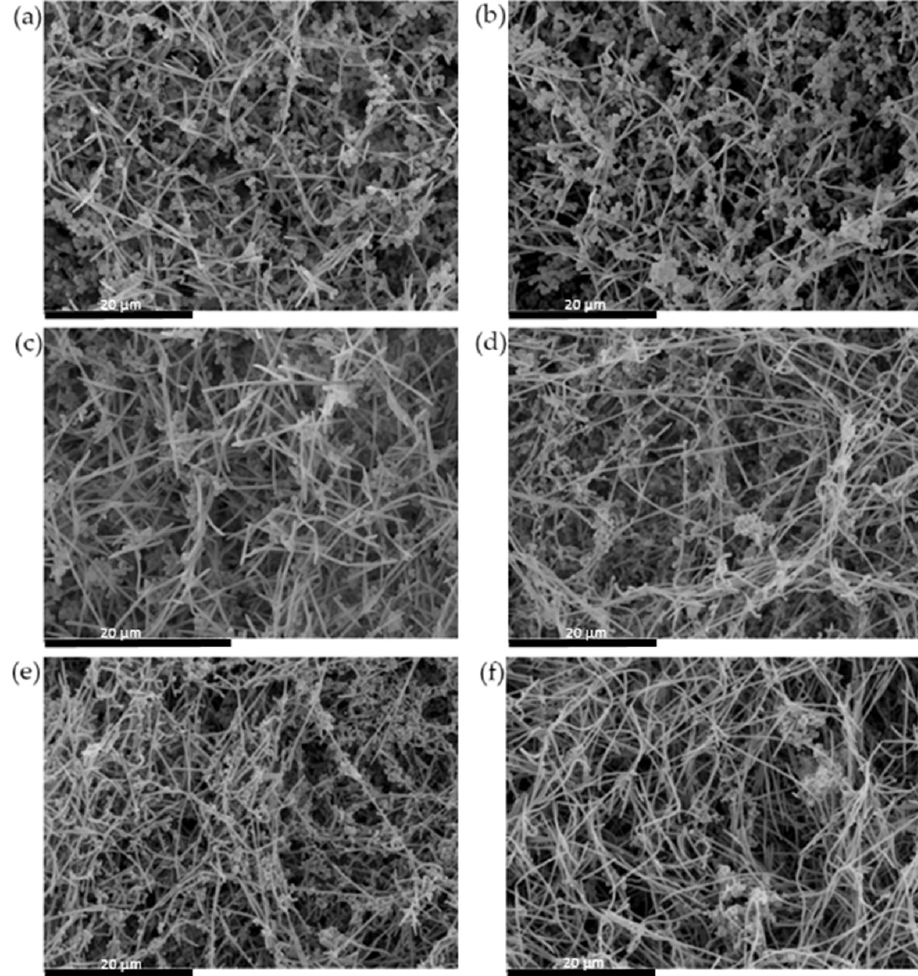
Figure 4. Scanning electron microscope images of the control biofilms ( a , c , e ), composed by Streptococcus mutans, Veillonella parvula, Actinomyces naeslundii, Fusobacterium nucleatum, Aggregatibacter actinomycetemcomitans and Porphyromonas gingivalis , and experimental biofilms, incorporating also Streptococcus downii sp. nov. ( b , d , f ), after 24 h ( a , b ), 72 h ( c , d ) and 120 h ( e , f ) of growth. A similar architecture of biofilms can be observed, in both presence and absence of S. downii sp. nov., with biofilms covering the disc surfaces with flat homogenous layers of cells, combined with bacterial clusters, showing channels inside the